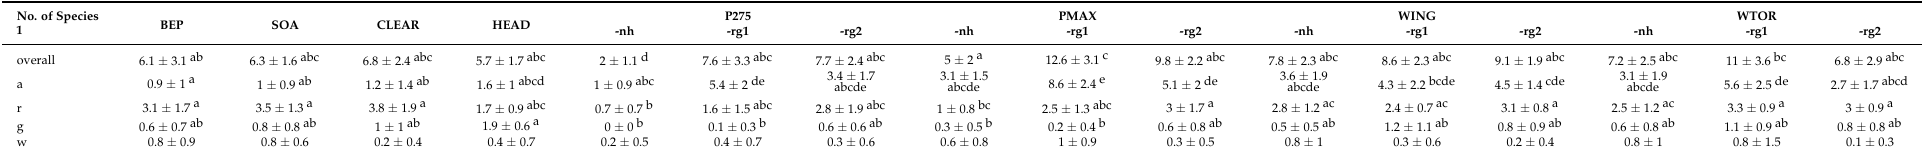
Table A1. Number of species (overall and separated by species of different habitat preferences) of the different SRC stand types at plot-level. Values with no consistent letter indicate significant differences ( p < 0.05). For abbreviations of stand types see Table